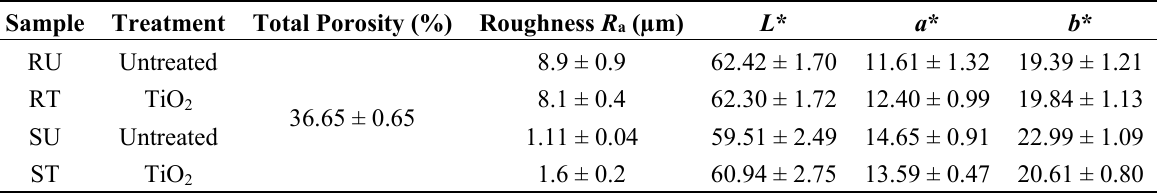
Table 1. Tested clay brick specimens with physical characteristics (mean value ± standard deviation). Each sample is representative of three specimens.